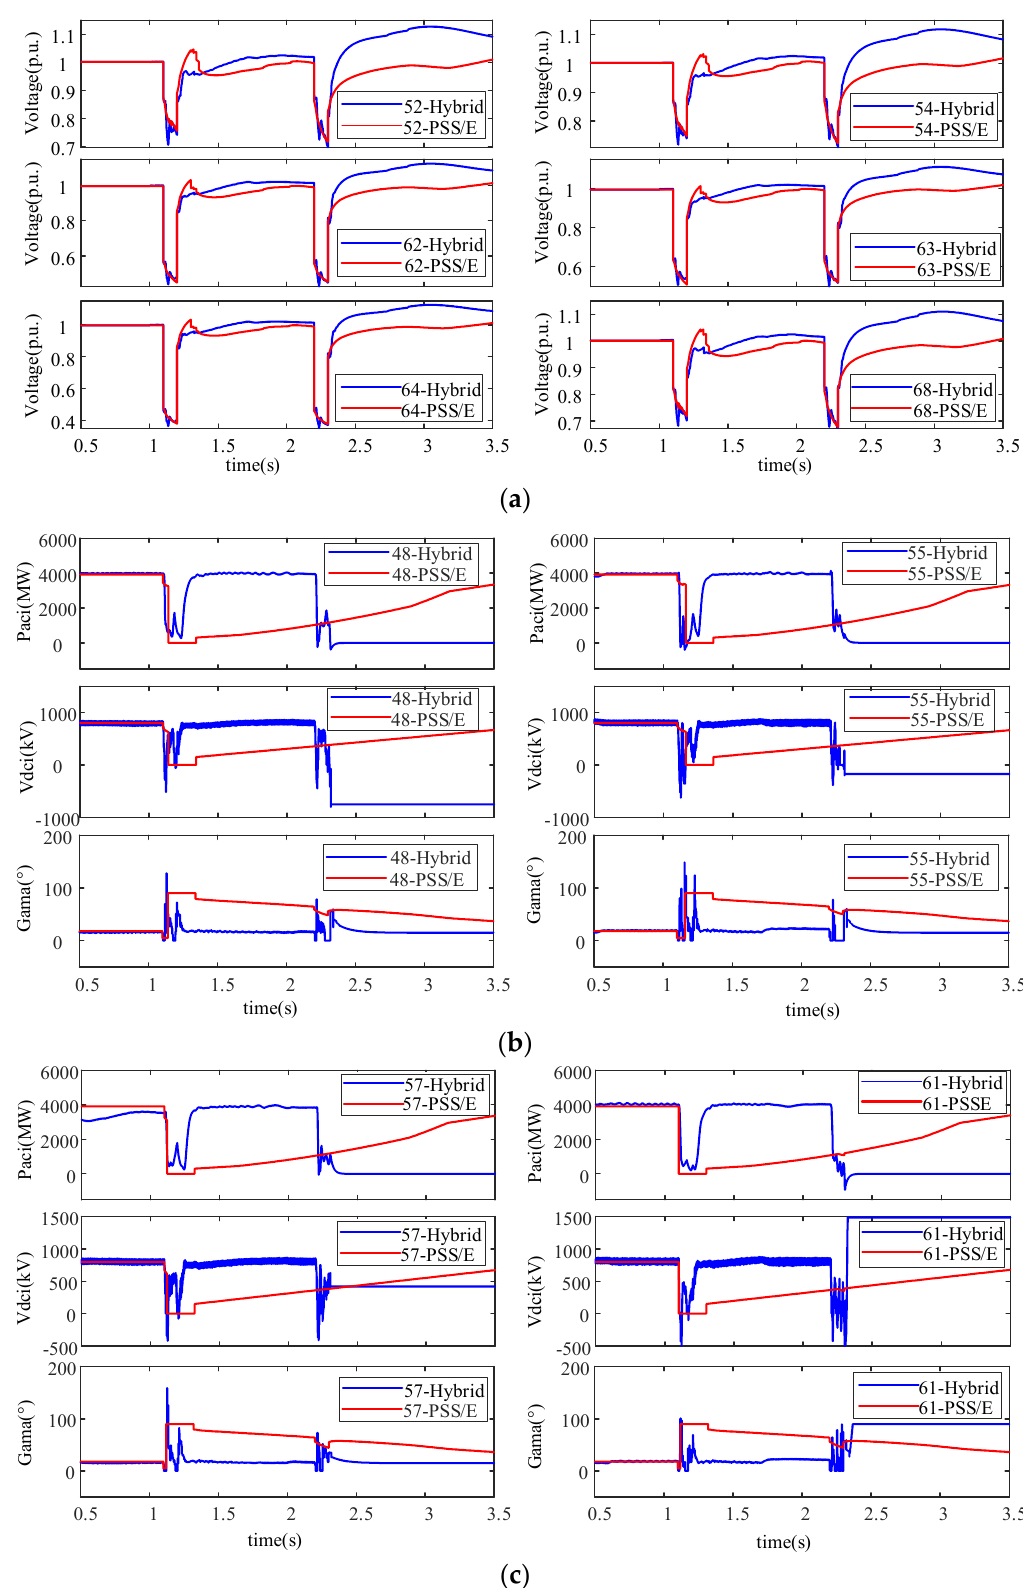
Figure 10. ( a ) Voltage of interface buses; ( b ) Active power, dc voltage and extinction angle at the